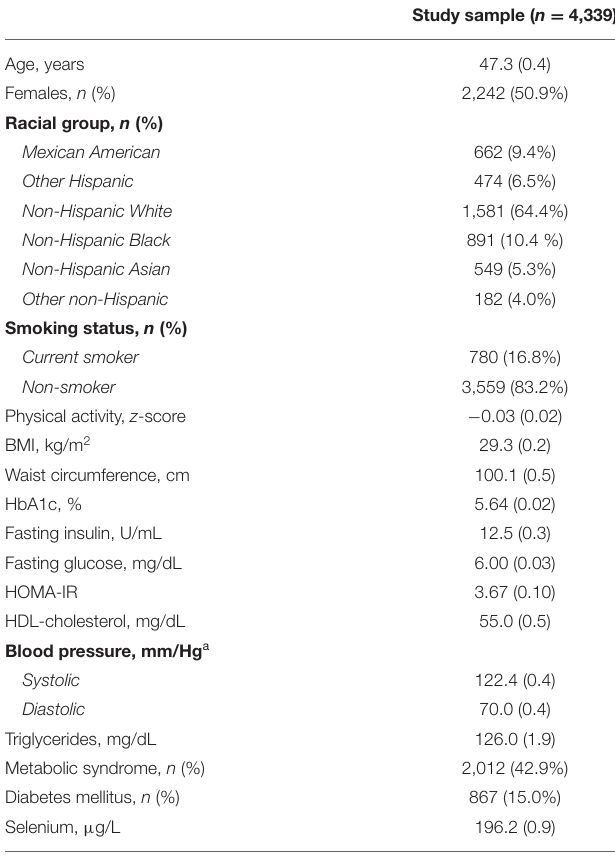
TABLE 1 | Demographic and clinical characteristics of US adults in the NHANES 2013–2018.